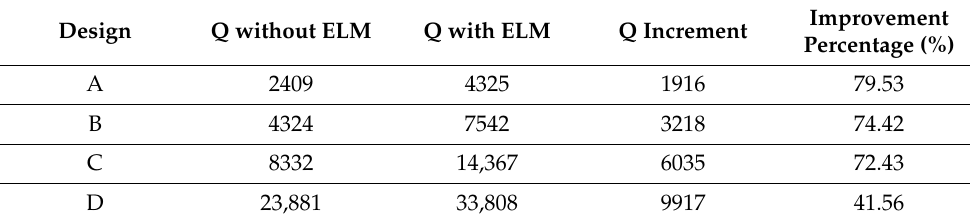
Table 2. Improvement of the Q value with the insertion of the